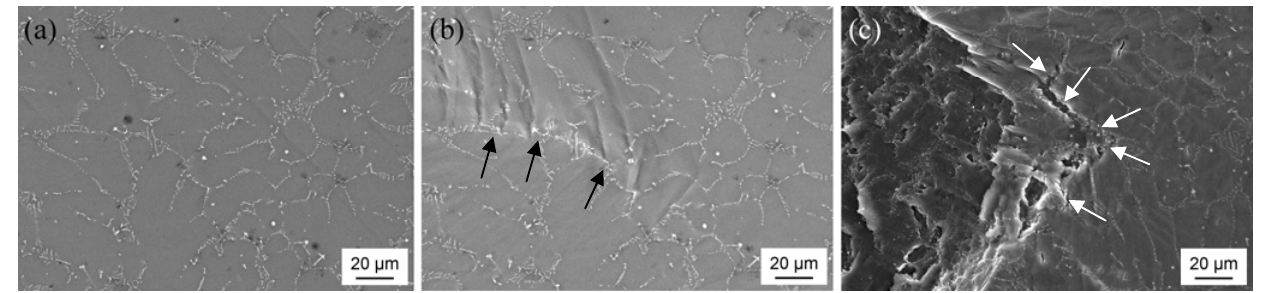
Figure 7. SEM investigation of the microstructure of the alloy Mg96Co4 during the in-situ tensile test: ( a ) specimen 1 in unloaded state; ( b ) specimen 1 loaded with 630 N; ( c ) fracture in specimen 2 after